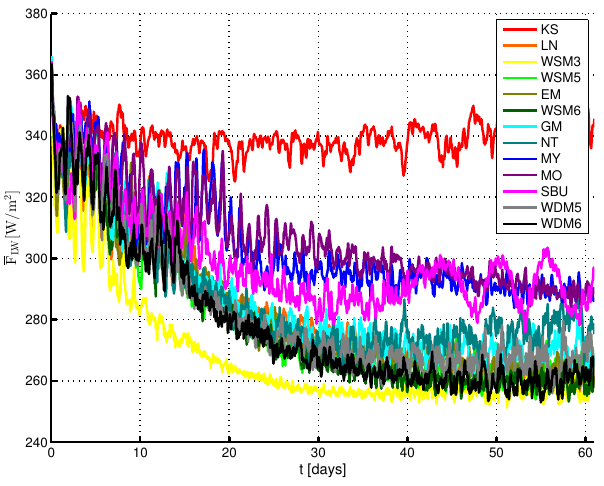
Fig. 9. Comparison of the mean DLR flux at the surface for the 13 microphysical schemes. The main source of DLR at the sur- face is water vapour emission from the atmosphere while the high- frequency variations are due to the grey-body emission coming from the cloud